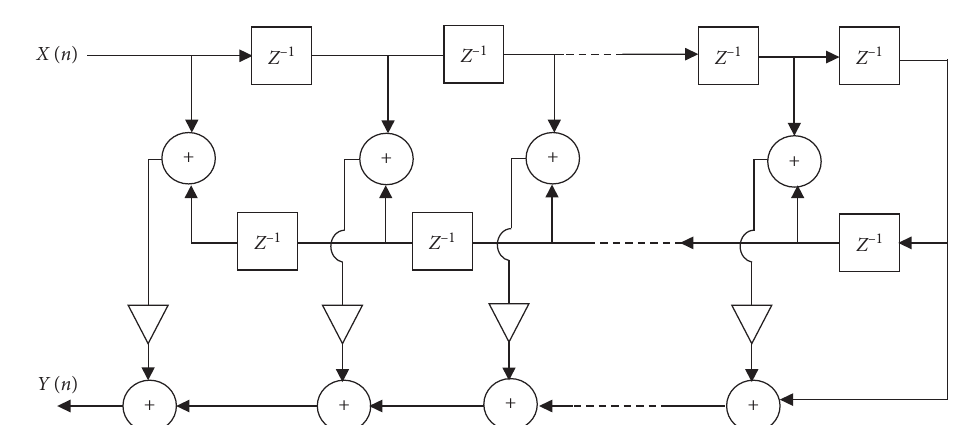
Figure 3: The symmetric structure of the linear-phase FIR filter.